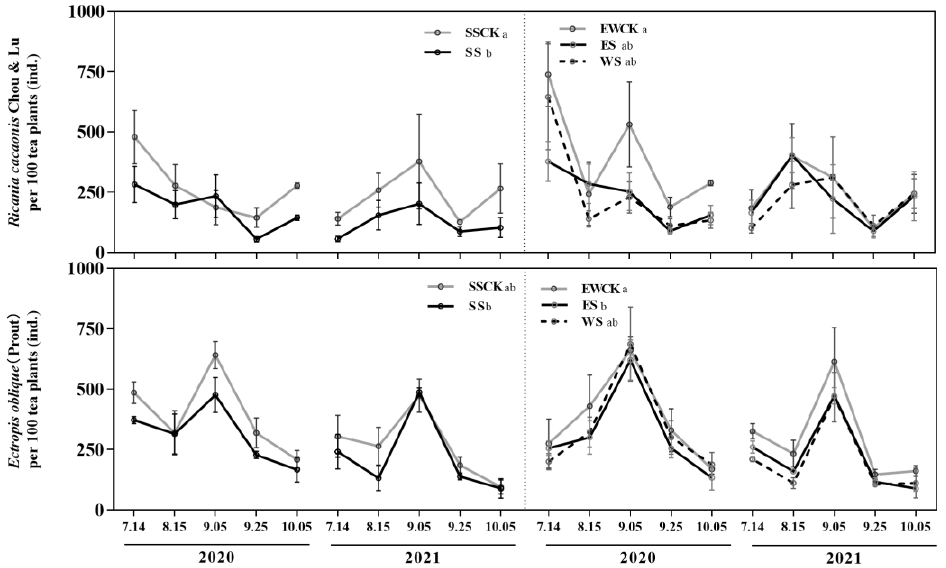
Figure 5. Population occurrence of two key pest species, R. cacaonis and E. oblique, in the ecological shading treatments with roadside trees in the tea plantation. (Note: different lowercase letters indicate significant differences among the ecological-shade treatments, and the control no-shading treatments, using the LSD test at p <